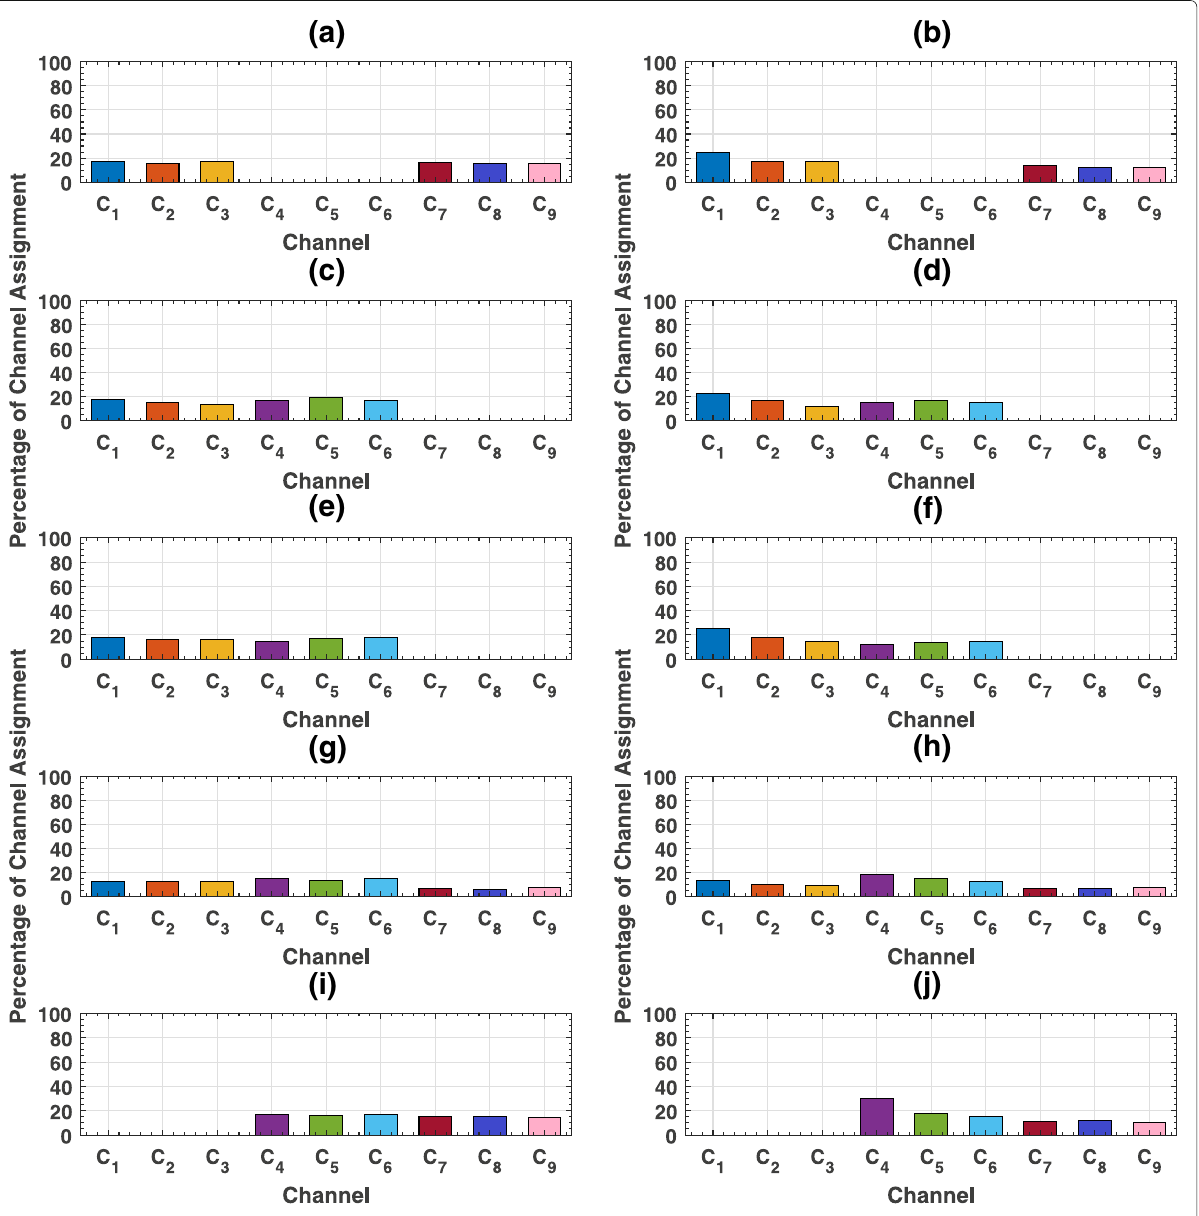
Fig. 10 Percentage of channel assignment—Scenario 2. a U 3 (U-SM). b U 3 (BS-SM). c U 4 (U-SM). d U 4 (BS-SM). e U 5 (U-SM). f U 5 (BS-SM). g U 6 (U-SM). h